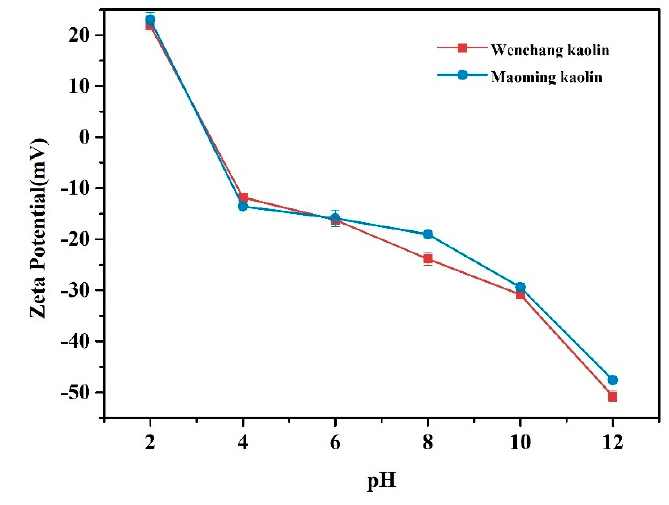
Figure 5. Zeta potential of kaolin samples with varying pH.